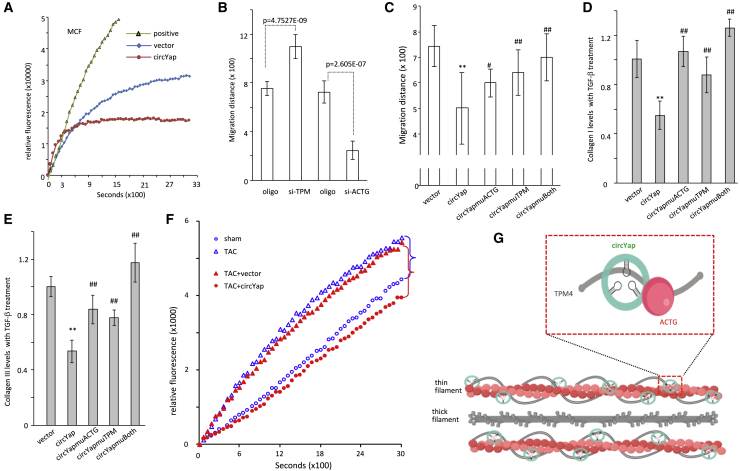
The Function Change of Heart Cells upon siRNA and Binding Sites Mutation(A) Actin polymerization rates in MCF cells transfected with control vector or circYap plasmids. Expression of circYap decreased actin polymerization. (B) The migration rates of MCF cells transfected with TPM4 siRNA, ACTG siRNA, or control oligo were tested by wounding assays. Silencing TPM4 increased cell migration, while silencing ACTG decreased cell migration. n = 7. ∗∗p < 0.01. (C) The migration rates of MCF cells transfected with vector control, circYap, and circYap constructs containing binding site mutations with ACTG and TPM4 (circYapmuACTG and circYapmuTPM). n = 9. ∗∗p < 0.01 versus vector, ##p < 0.01 versus circYap. (D and E) The levels of collagen-I and collagen-III in vector control, circYap, and circYap constructs containing binding site mutations with ACTG and TPM4 (circYapmuACTG and circYapmuTPM). n = 4. ∗∗p < 0.01 versus vector, ##p < 0.01 versus circYap. (F) In the heart tissues of TAC mice, reduction of circYap expression increased actin polymerization. Ectopic delivery of circYap decreased actin polymerization. (G) Diagram of circYap binding with ACTG and TPM4 forming complexes, playing roles in actin polymerization and tissue contraction.